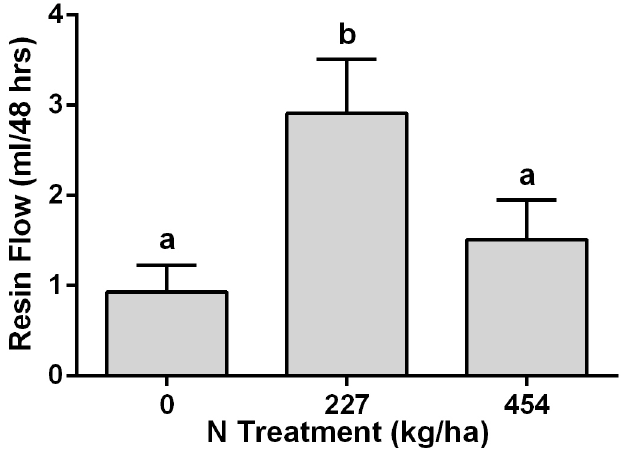
Figure 1. Mean (+SEM) resin flow (mL) during a 48-h period for lodgepole pines that